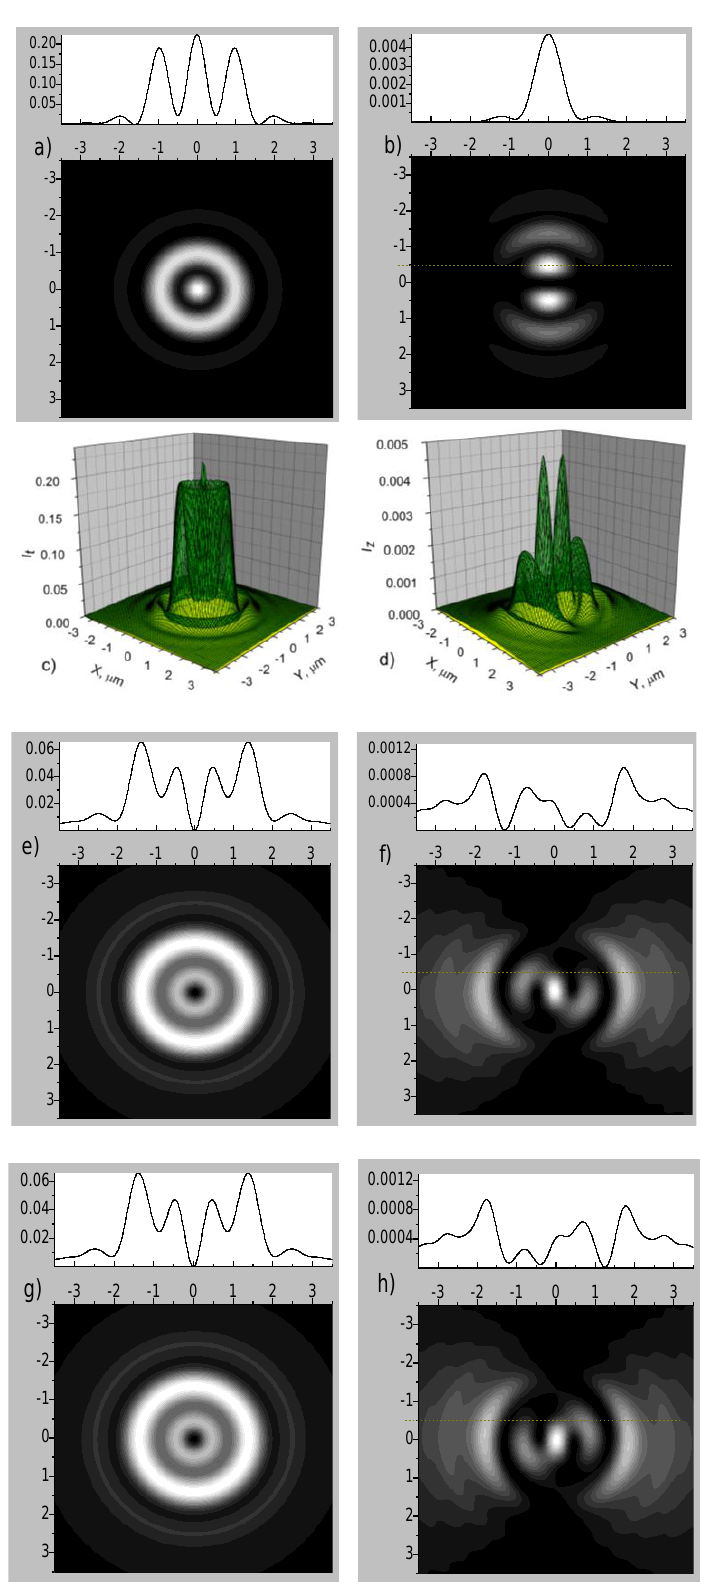
Figure 8. Intensity distributions of the transverse electric field component (left column) and the longitudinal electric field component (right column) in the focal planes z f = 331 µ m ( a – d ) and z f = 333 µ m ( e – h ): ( a , b ) l = 0; ( c , d ) l = 0 —3D intensity patterns; ( e , f ) l = 1; ( g , h ) l = −